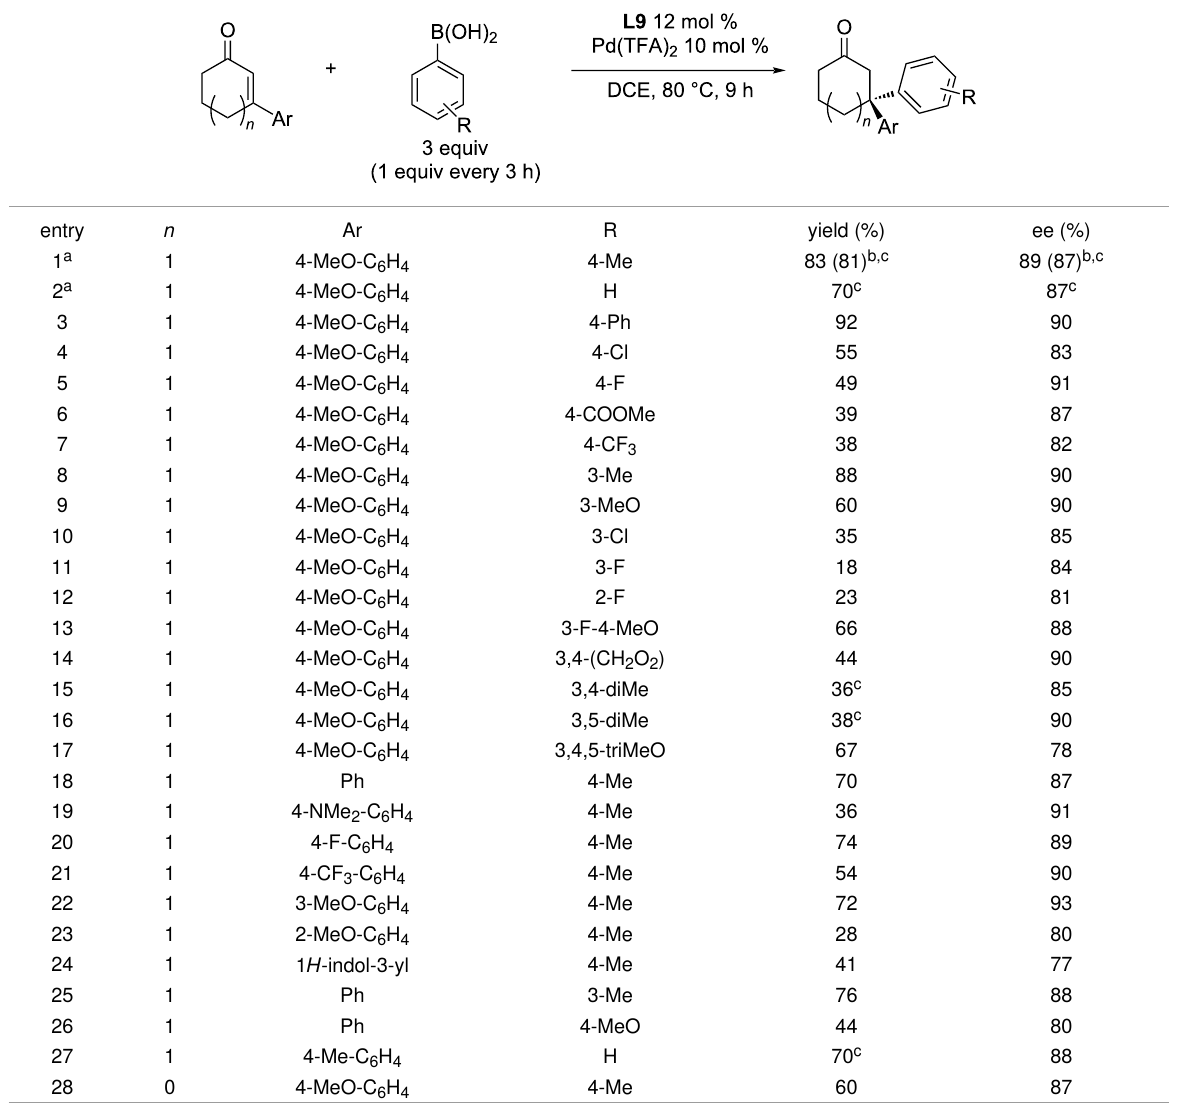
Table 27: Addition reactions of arylboronic acids to 3-aryl-2-cyclohexenones catalysed by L9 /Pd(TFA) 2